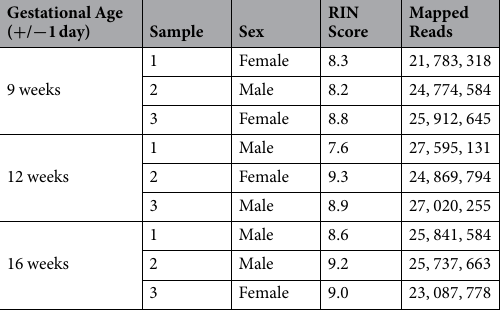
Table 1. Sample quality and sequencing information for each